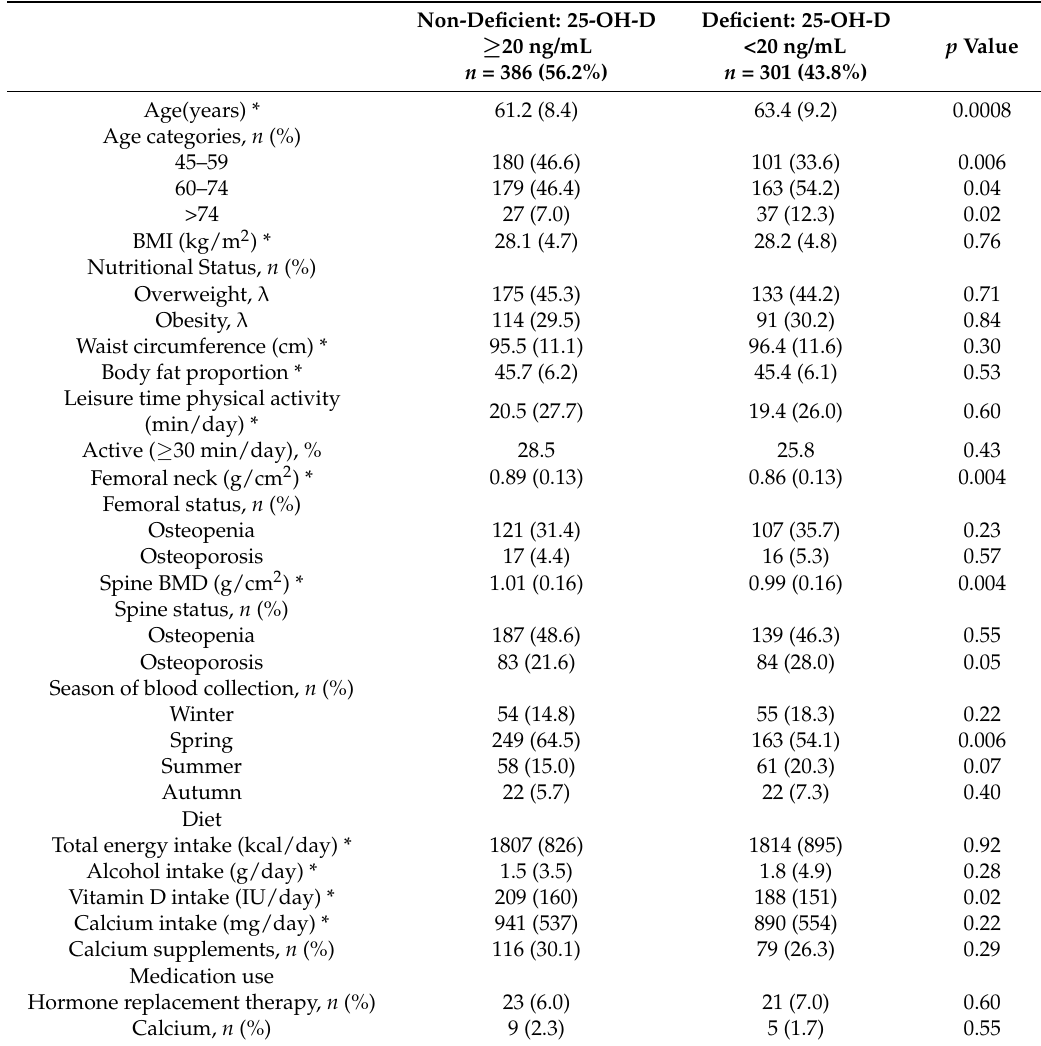
Table 2. Characteristics of postmenopausal women of the Health Workers Cohort Study by vitamin D status